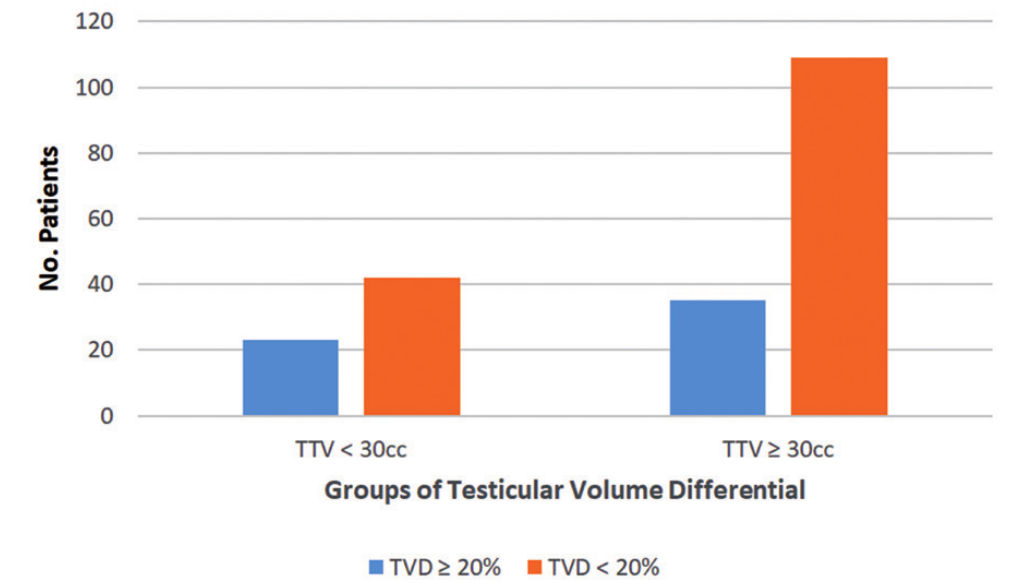
figure 1 - Number of males with TvD ≥ 20% and < 20% grouped by